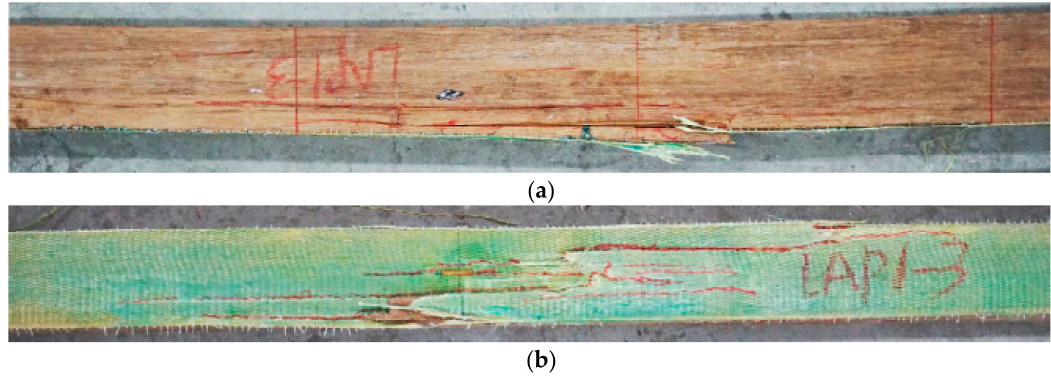
Figure 4. This is the typical failure photos for mode I (LAP1-3): ( a ) side surface; ( b ) bottom